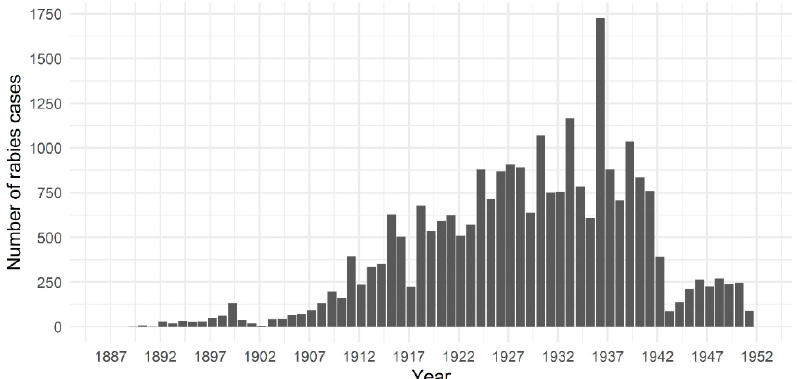
Figure 1. Total number of rabies cases reported each year in all animal species in British India between 1887 and 1951 (annual data span April to the following March, e.g., April 1887 to March 1888). Statistics were compiled from annual reports of the Civil Veterinary Department of the colonial British Government of India, available at https://digital.nls.uk/indiapapers/.